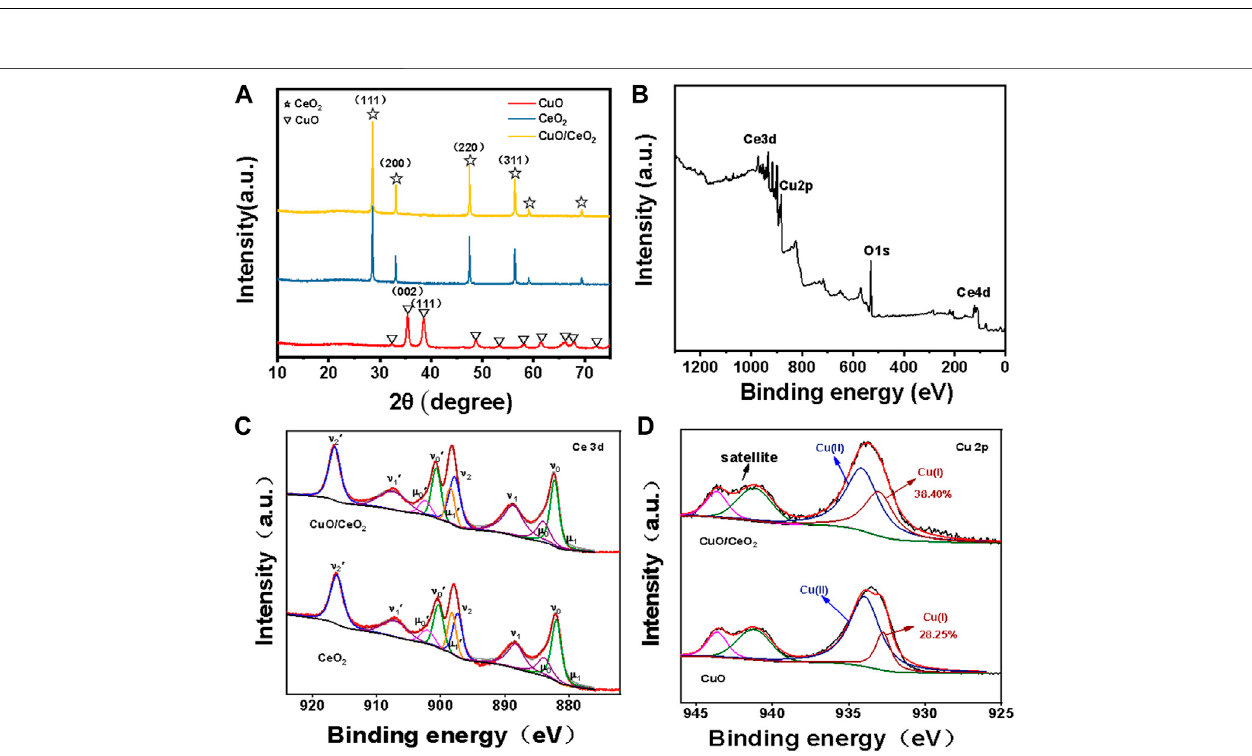
2 and CuO/CeO 2 .